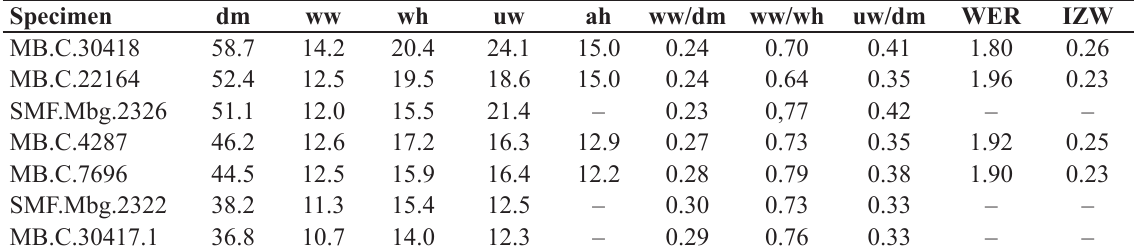
Table 1. Conch dimensions (partly reconstructed) and ratios of selected specimens of Pseudoprobeloceras pernai (Wedekind,